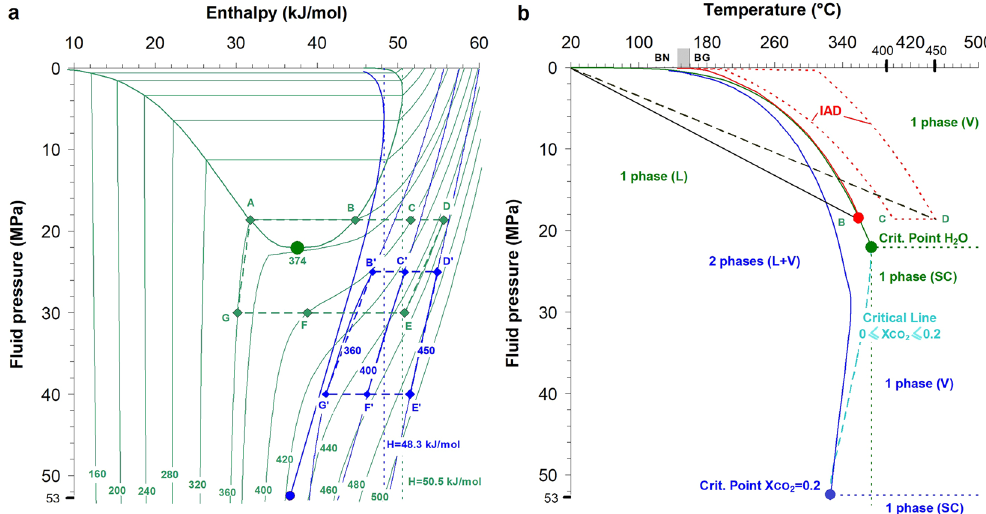
Figure 3. P-H-T properties of the hydrothermal system. ( a ) P fluid -H diagrams for pure water (thin green lines: isotherms; thick green line: vapour-liquid equilibrium) and for a H 2 O-CO 2 80:20 (mol) mixture (thin blues lines: isotherms; thick blue line: vapor-liquid equilibrium-dew line). Green and blue labels refer to pure water and H 2 O-CO 2 mixture, respectively. Numbers labeling isotherms refer to °C. See Methods for source of data. ( b ) Vapor-liquid equilibria and phase fields for pure water (green line and green labels) and for the 80:20 H 2 O-CO 2 mixture (blue line and blue labels), together with the critical line for intermediate fluid compositions (turquoise line). L: Liquid; L + V: coexisting liquid and vapor; SC: supercritical gas. Also shown (with respect to pure water only, for the sake of graphical clarity) are: 1) the P-T path of the 1982-84 fluid plume (solid red line), 2) the locus of condensation-free ascent fluid paths between 2001 and 2013 (enveloped by the dotted closed red line), and 3) the P-T paths outside the hot fumarolic area (solid and dotted black straight lines). See Methods for sources of